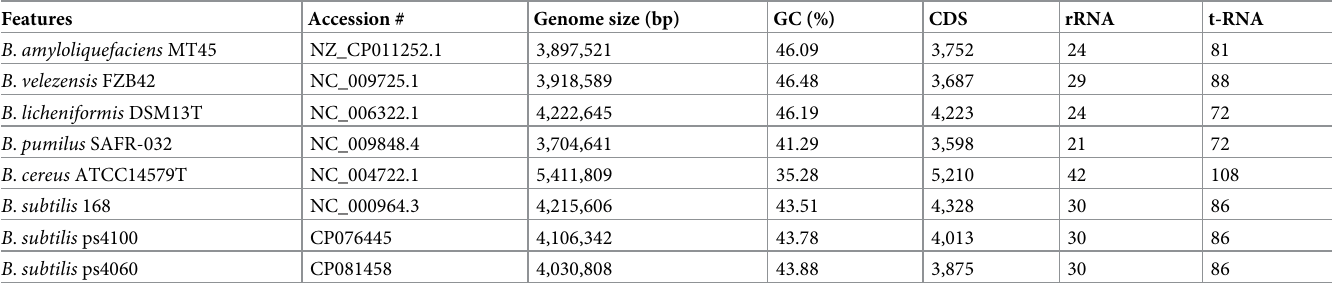
Table 1. Genome comparisons among Bacillus species.